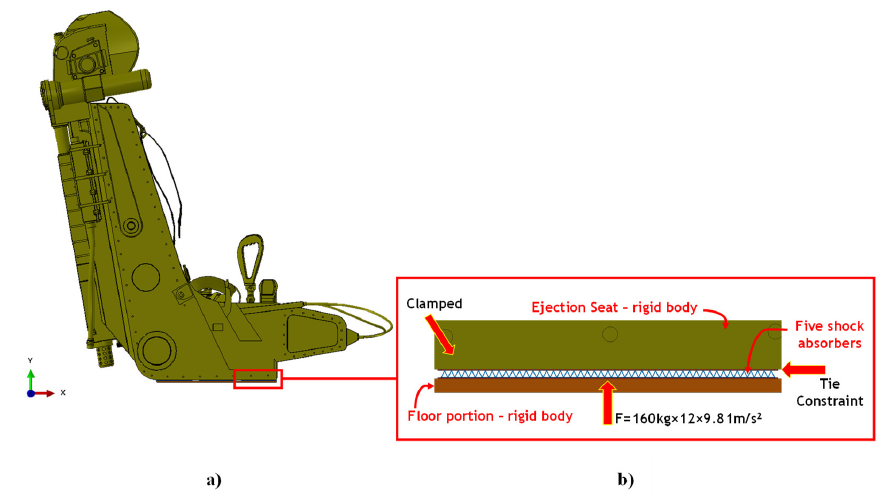
Figure 12. Simulation of the starting primary acceleration phase. ( a ) general view; ( b ) details.